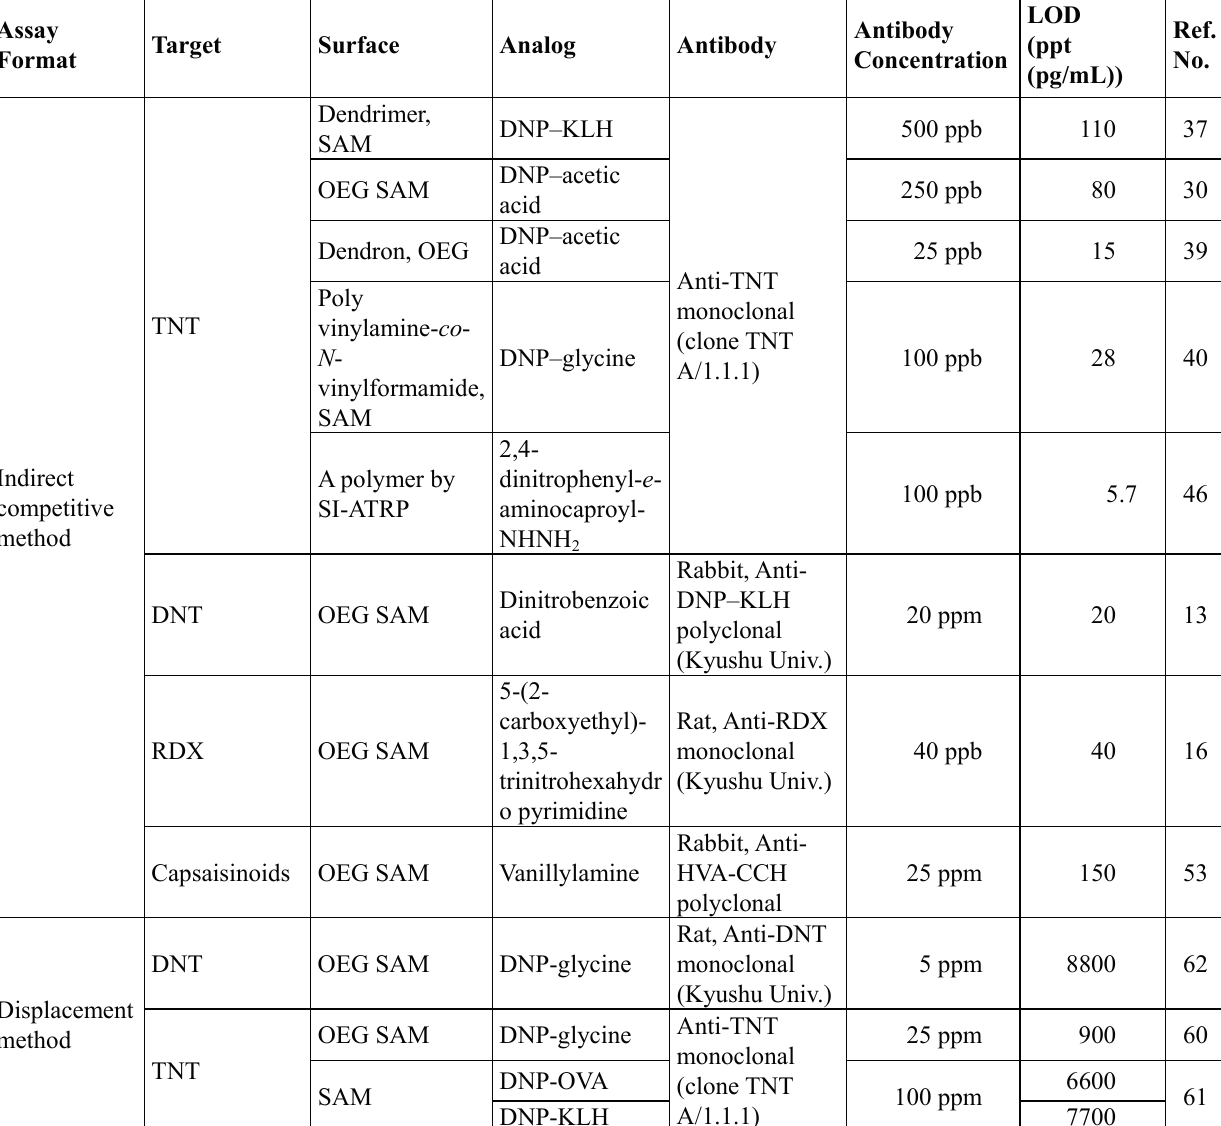
Table 2. A summary of SPR immunoassays of explosives,